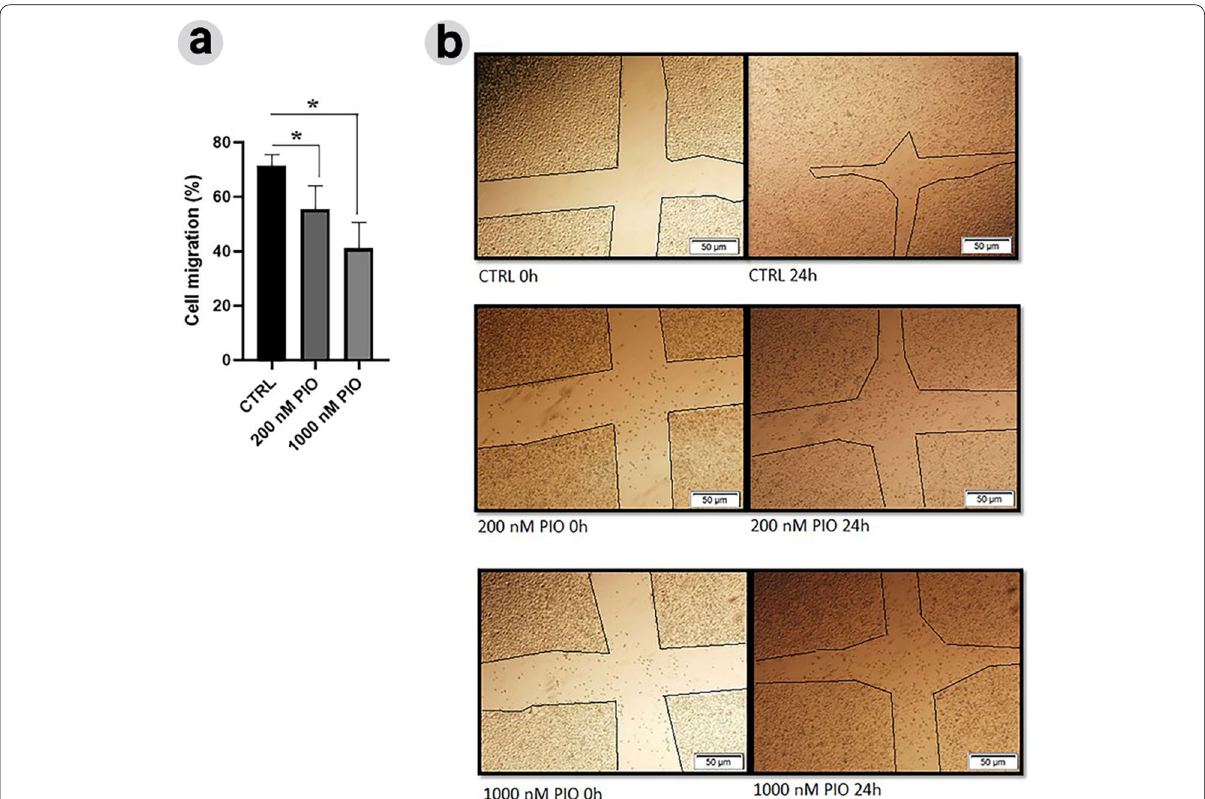
Fig. 3 a The percentage of the wound area filled by migrated cells after 24 h analyzed with ImageJ in groups treated with 200 and 1000 nM of PIO compared with the control group ( P 0.049). b The pictures of the wound areas after 24 h in cells treated with 200 and 1000 nM PIO compared to = the control